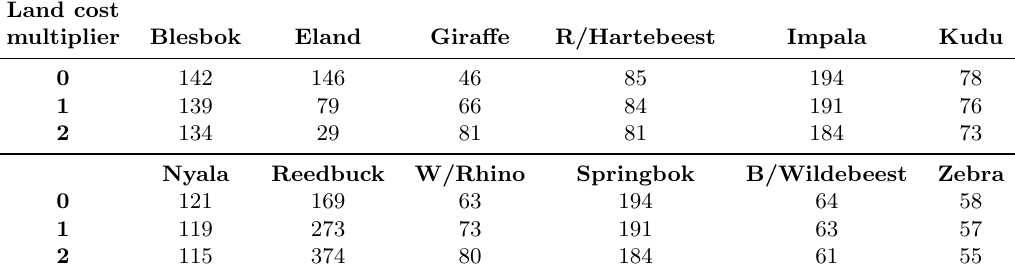
Table 3: The effect of the cost of land on the optimal population numbers of each species. The nominal cost of land is multiplied by 0, 1 and 2 as indicated. For each case the three objectives (returns, risk and Q ) in (6) are equally